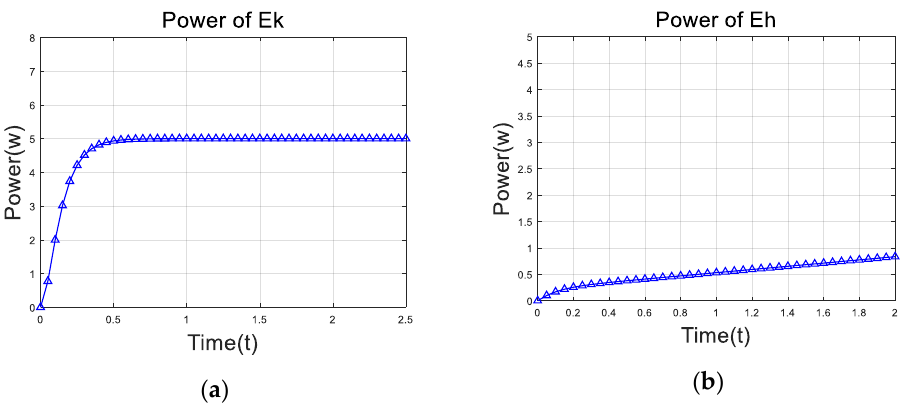
Figure 5. Ec, Ef, and Ee change versus time. ( a ) Ec changes versus time, ( b ) Ef changes versus time, ( c ) Ee changes versus time.